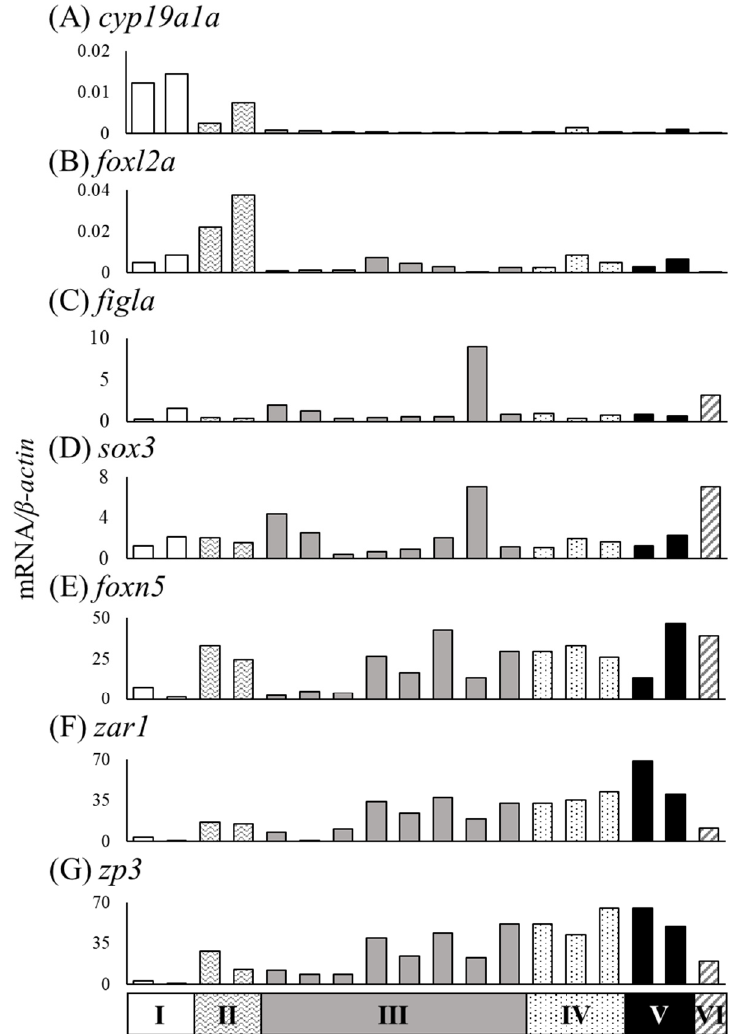
Figure 9. Relationships between stages of ovarian development and mRNA levels in gonads of the wild Japanese eel Anguilla japonica. ( A ) cyp19a1a , ( B ) foxl2a , ( C ) figla , ( D ) sox3 , ( E ) foxn5 , ( F ) zar1 and ( G ) zp3 mRNA levels in the ovaries of groups I–VI. Each column indicates mRNA levels that are normalized against levels of β -actin . TL in eels of groups A–F; for details, refer to Table 4.